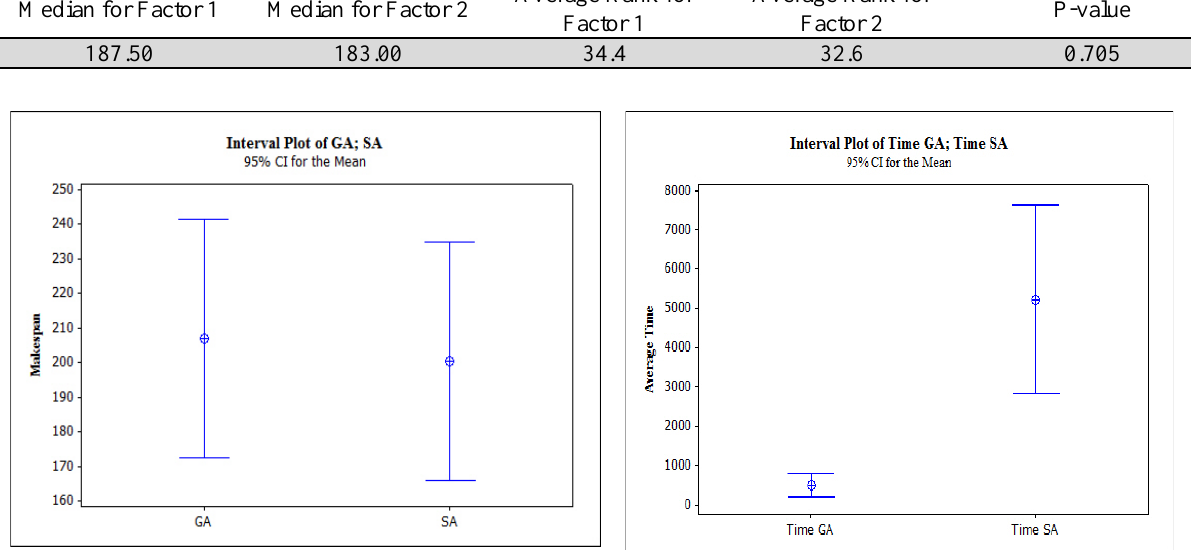
Fig. 6. Interval plot for obtained makespan from suggested algorithms (small and large problems)